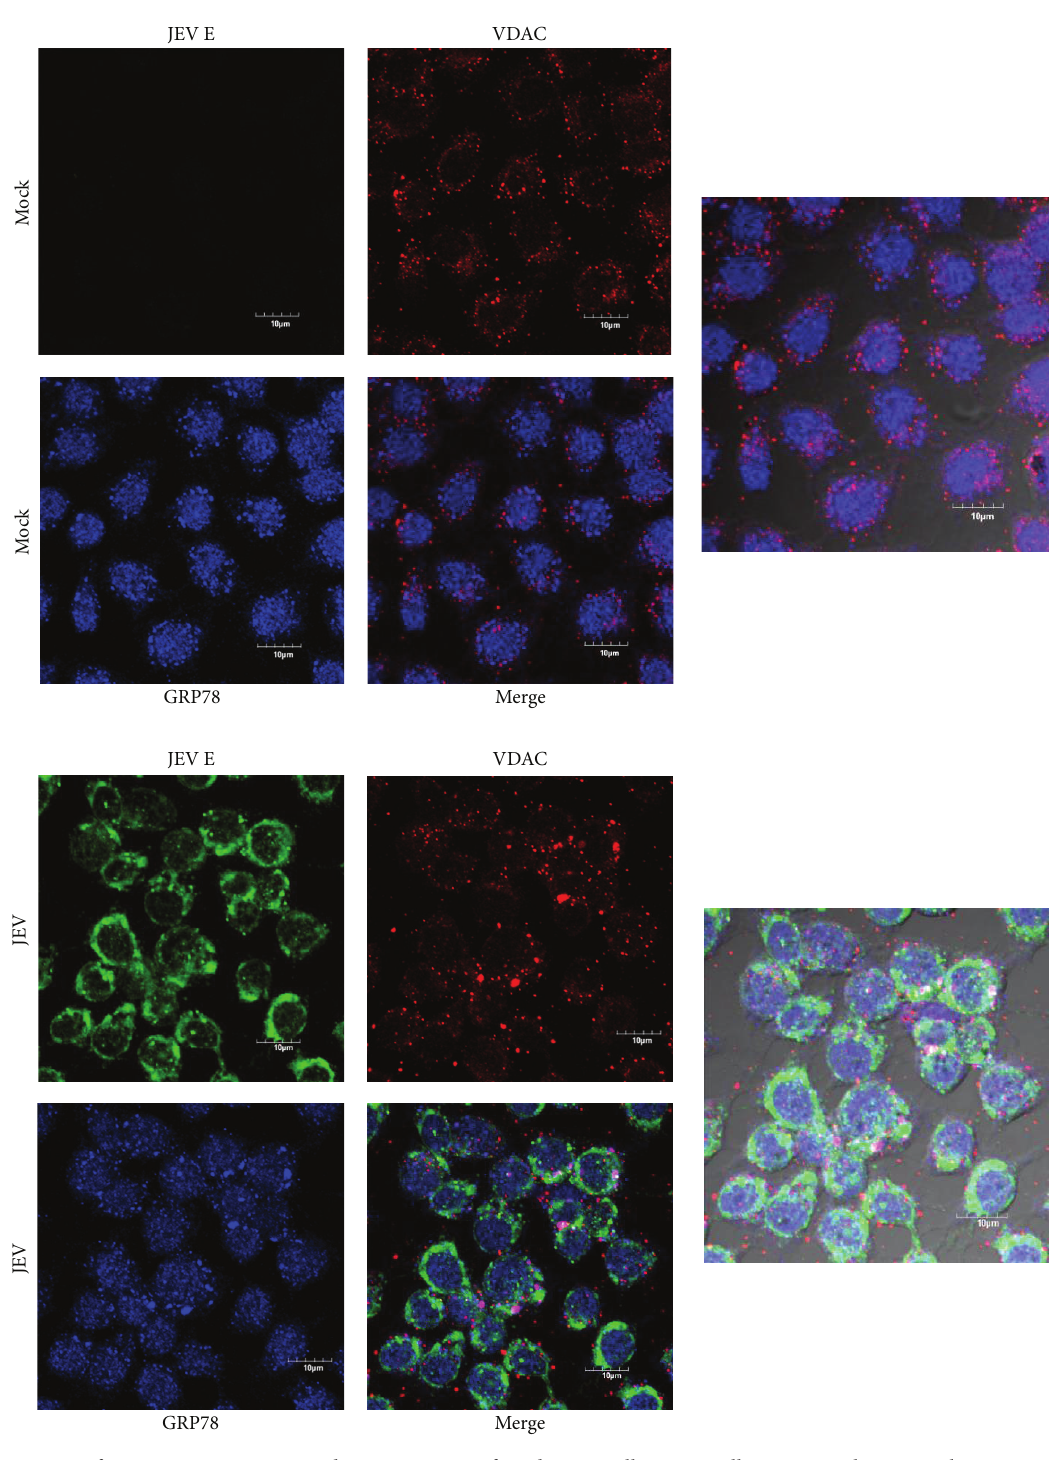
Figure 3: Location of JEV E protein, VDAC, and GRP78 in JEVinfected C6/36 cells. C6/36 cells grown on glass cover slips were mock infected or infected with JEV and examined for location of JEV E protein (green), VDAC (red), and GRP78 (blue) using an Olympus FluoView 1000 confocal microscope. Representative individual and merged images are shown, and one panel has bright field